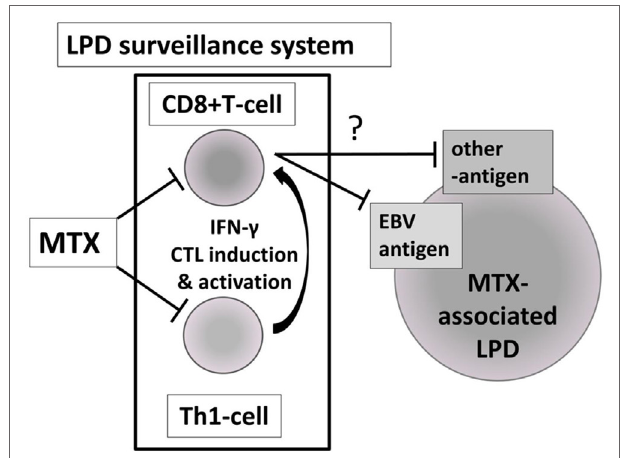
Figure 9 | Hypothesis of the pathological and regression mechanism of “regressive LPD” as a narrow sense of “MTX-associated LPD”. MTX, methotrexate; LPD, lymphoproliferative disorder; Th1, T helper 1; EBV, Epstein–Barr